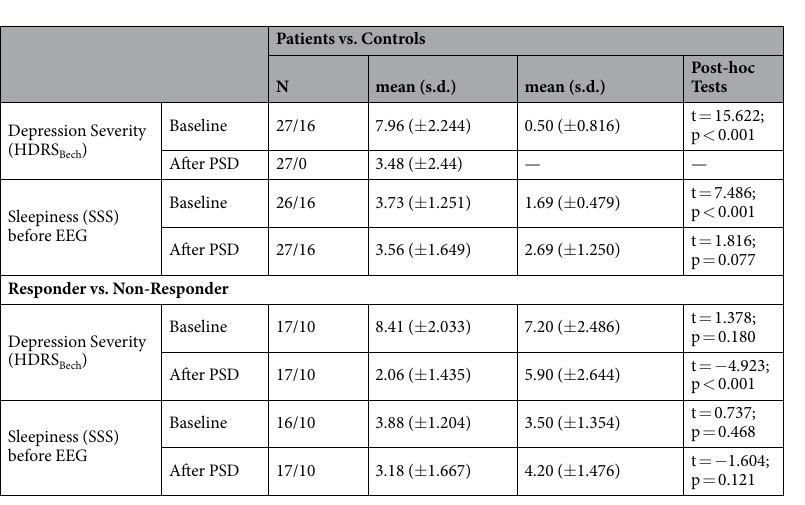
Table 4. Mood and sleepiness ratings (Means ( ± Standard Deviations)) in patients vs. healthy controls (left part) and responding vs. non-responding patients (right part) at baseline and after partial sleep deprivation (PSD). Annotations: HDRS Bech = Hamilton Depression Rating Scale Score according to Bech et al . 22 ; SSS = Stanford Sleepiness Scale; s.d. = standard